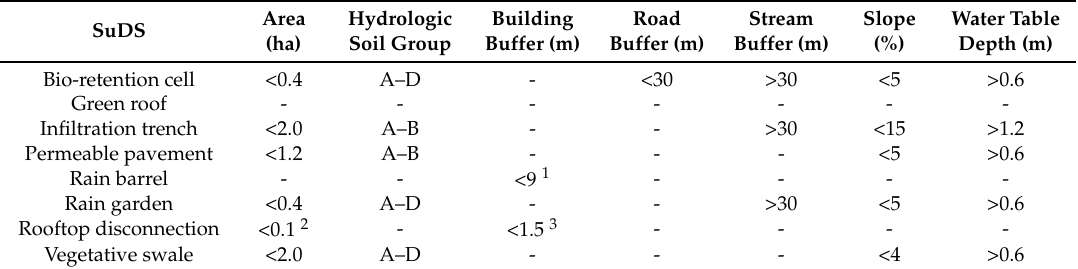
Table 1. Site feasibility criteria for the location of Sustainable Drainage Systems (SuDS) [25–29].